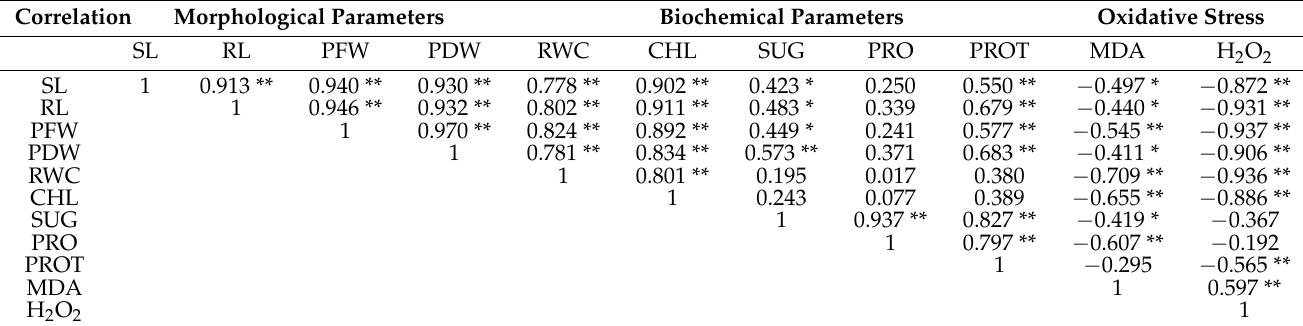
Table 4. Pearson correlation coefficients (r) between morphological, biochemical, and oxidative stress parameters of soybean seedlings, where SL—shoot length; RL—root length; PFW—plant fresh weight; PDW—plant dry weight; RWC—relative water content; CHL—chlorophyll; SUG—sugar; PRO—proline; PROT—protein; MDA—malonaldehyde; H 2 O 2 —hydrogen